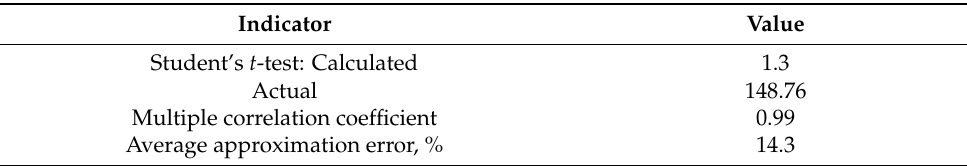
Table 4. The results of the evaluation of the model of changes in the trip distribution function of the workers of the city-service enterprises.